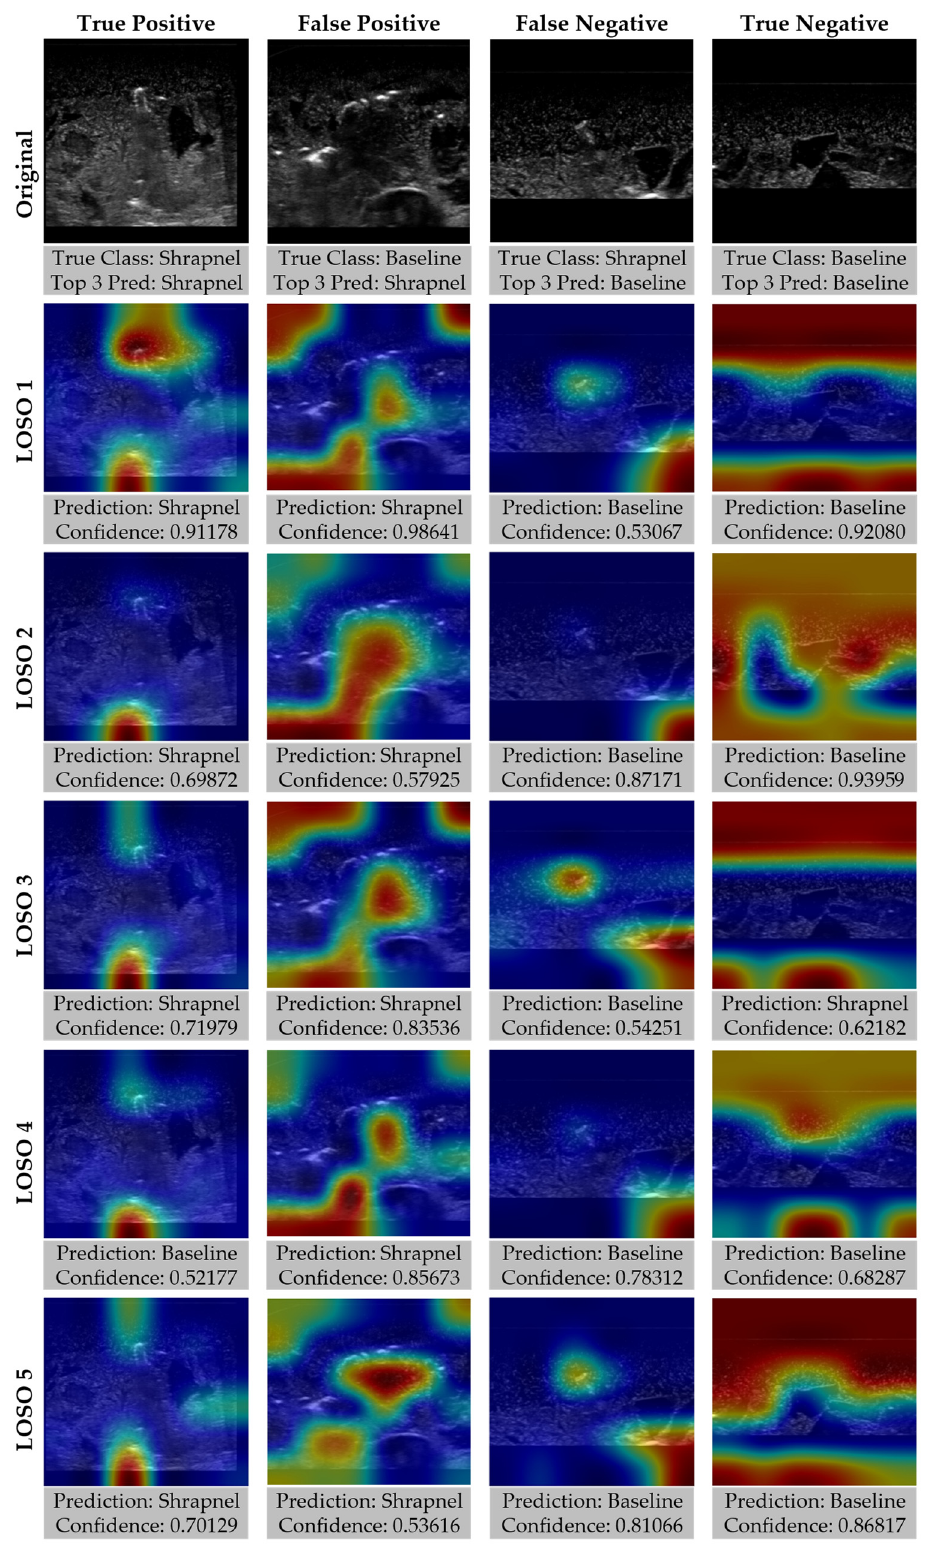
Figure 9. Gradient-weighted class activations mapping overlays for each LOSO holdout for ShrapML model including affine transformations and MixUp data augmentation. Representative images for true positive, true negative, false positive, and false negative prediction categories are shown along with GradCAM overlays for each LOSO, with prediction and confidences.